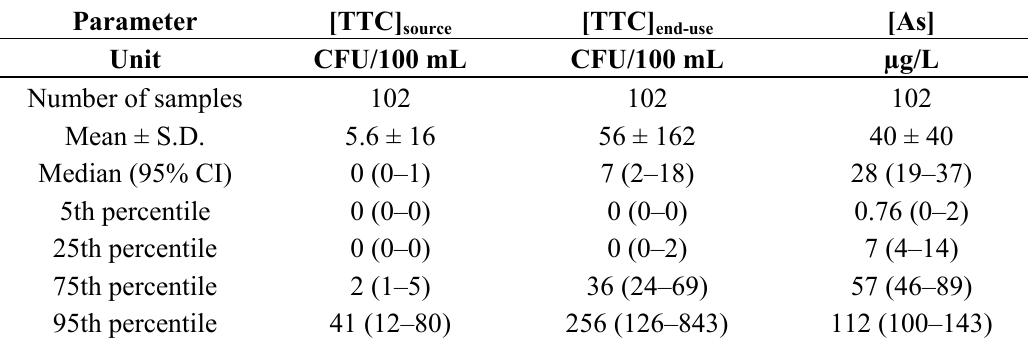
Table 3. Summary of water